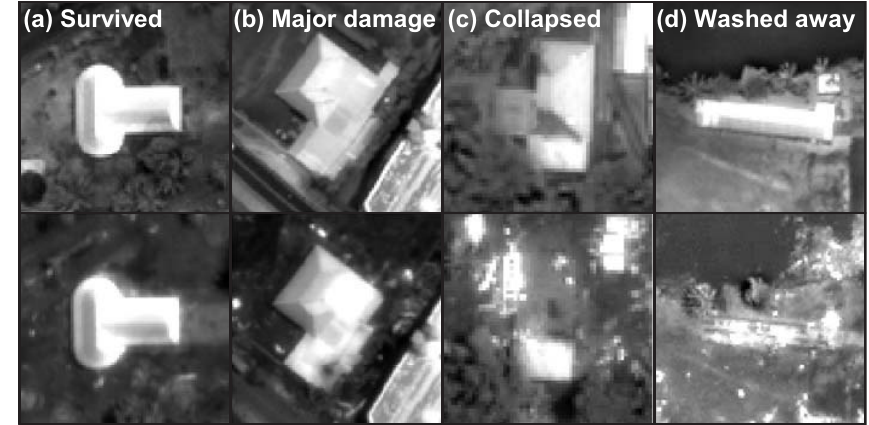
Figure 5. Classification criteria based on the remote sensing technology (upper photo: pre-tsunami; lower photo: post-tsunami).